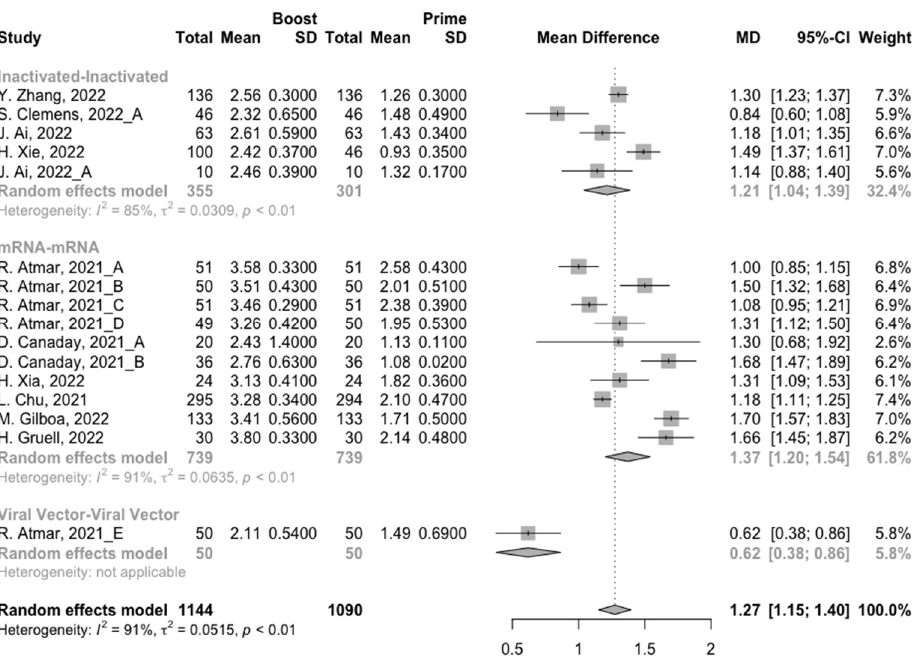
Figure 5. Forest plot of the pooled log-transformed neutralization titers against the wild type before and after homologous booster vaccination [2,18–32].